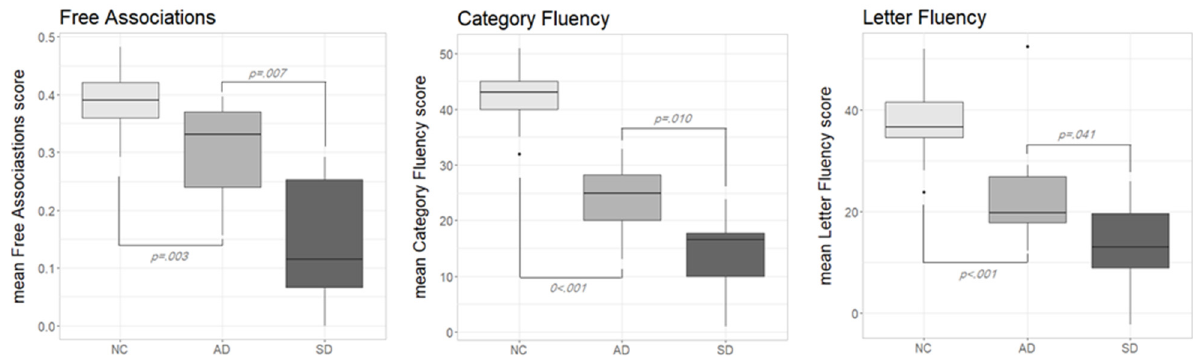
Figure 1. Boxplots showing the performance in the three diagnostic tasks according to participants group. AD—participants with Alzheimer’s disease, NC—normal controls, SD—participants with semantic dementia.